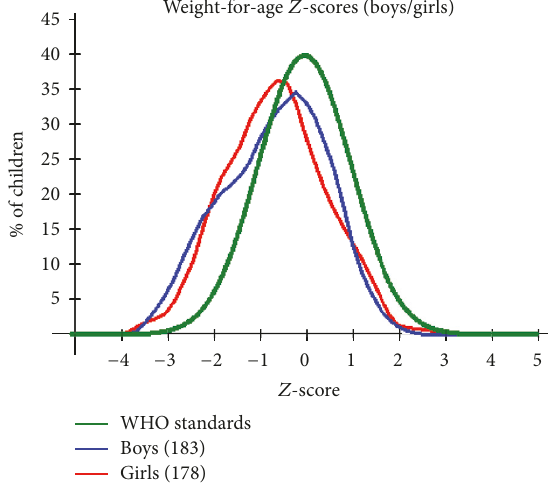
Figure 3: A plot of weight for age 𝑍 -scores by gender for the PSAC in Mwea Division against the WHO recommended